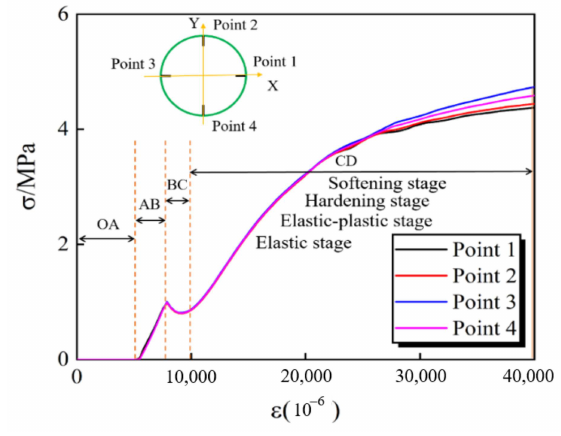
Figure 13. The relationship between contact pressure and vertical